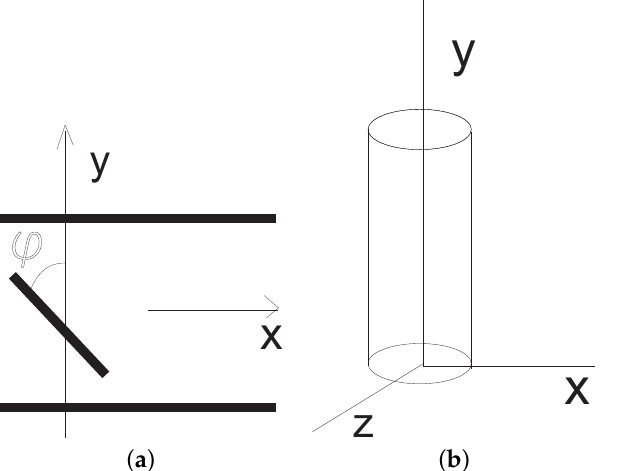
Figure 1. ( a ) Schema of particle’s position in one-dimensional flows. ( b ) The cylinder approximation of the rod-like